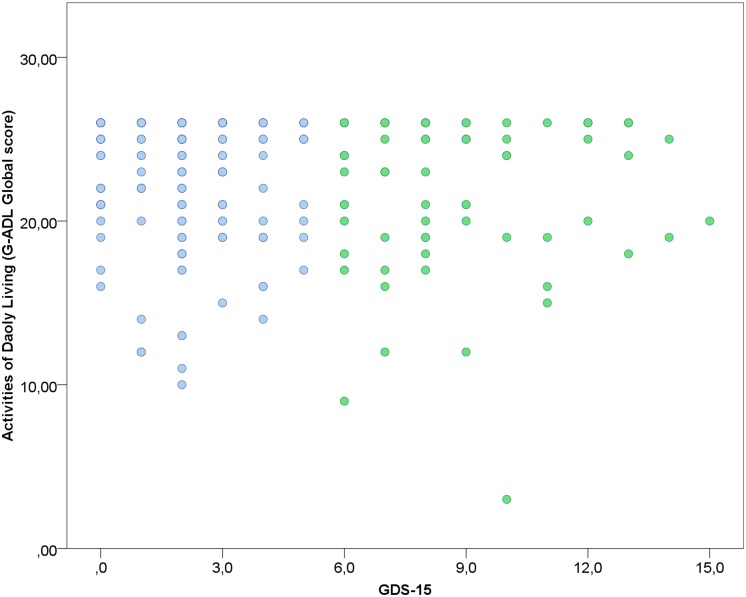
Association between depression and GADL scores. A weak correlation was observed between depressive status and GADL total score (r = -0.151, p = 0.013). In the scatterplot, blue dots represent the participants under the cut-off for depression according to the Geriatric Depression Scale and green dots the participants above the cut-off for depression. The number of dots in the scatterplot differs from the sample size due to superposed values.